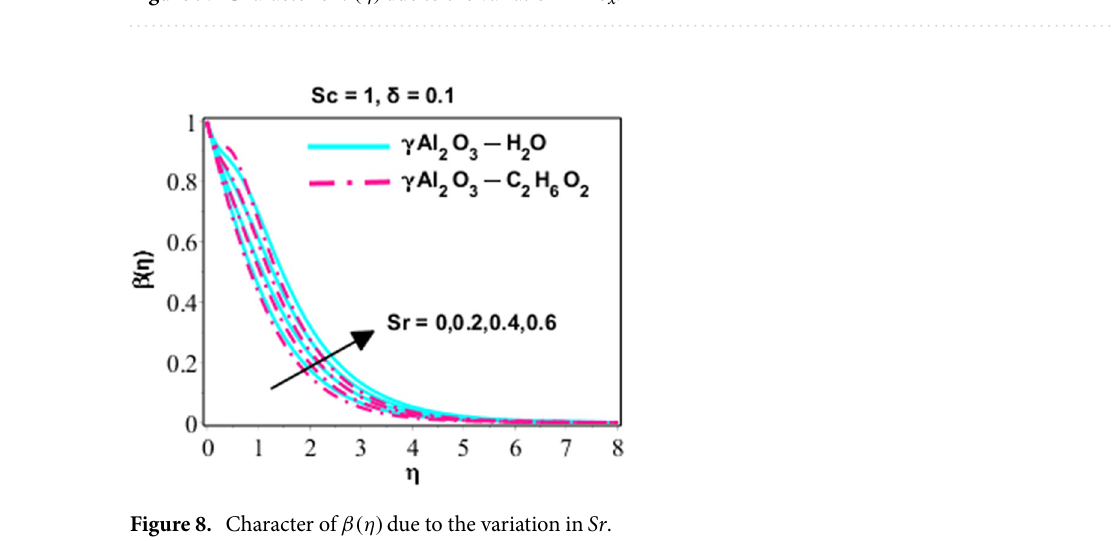
Figure 7. Character of θ(η) due to the variation in Ec x .